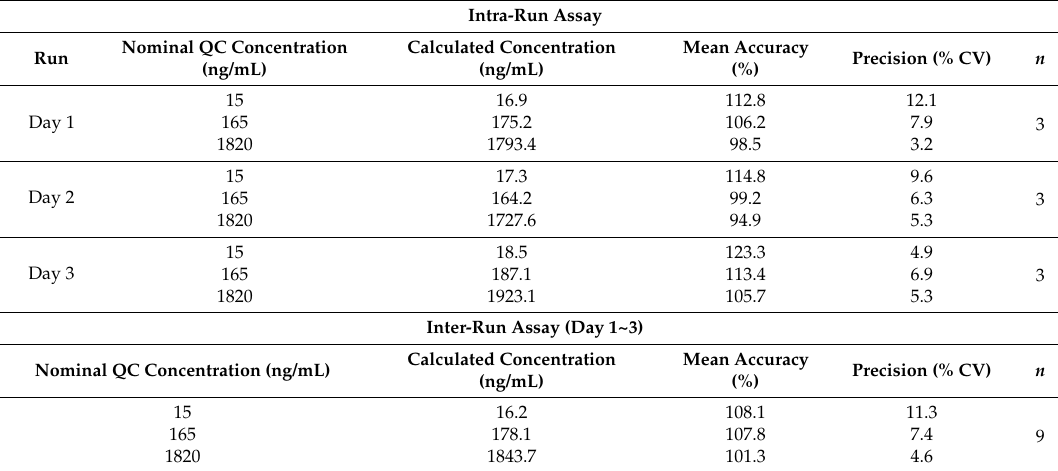
Table 2. Quality control results and statistics from the intra/inter-run assays for vipadenant.